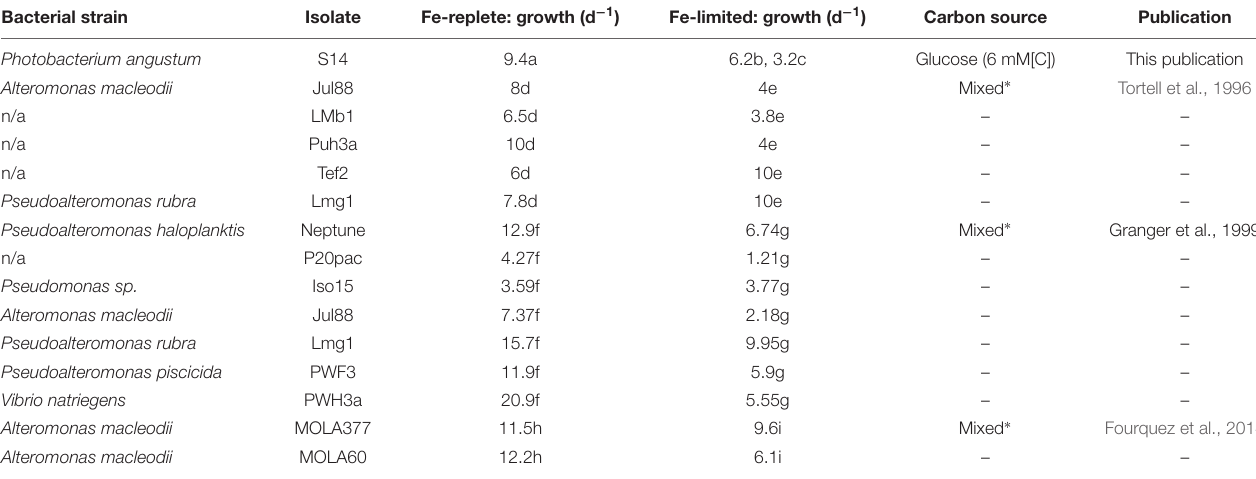
TABLE 2 | Results of previous publications including this publication depicting growth rates (per day) of marine heterotrophic bacteria grown in Aquil and in either Fe-replete or Fe-limiting